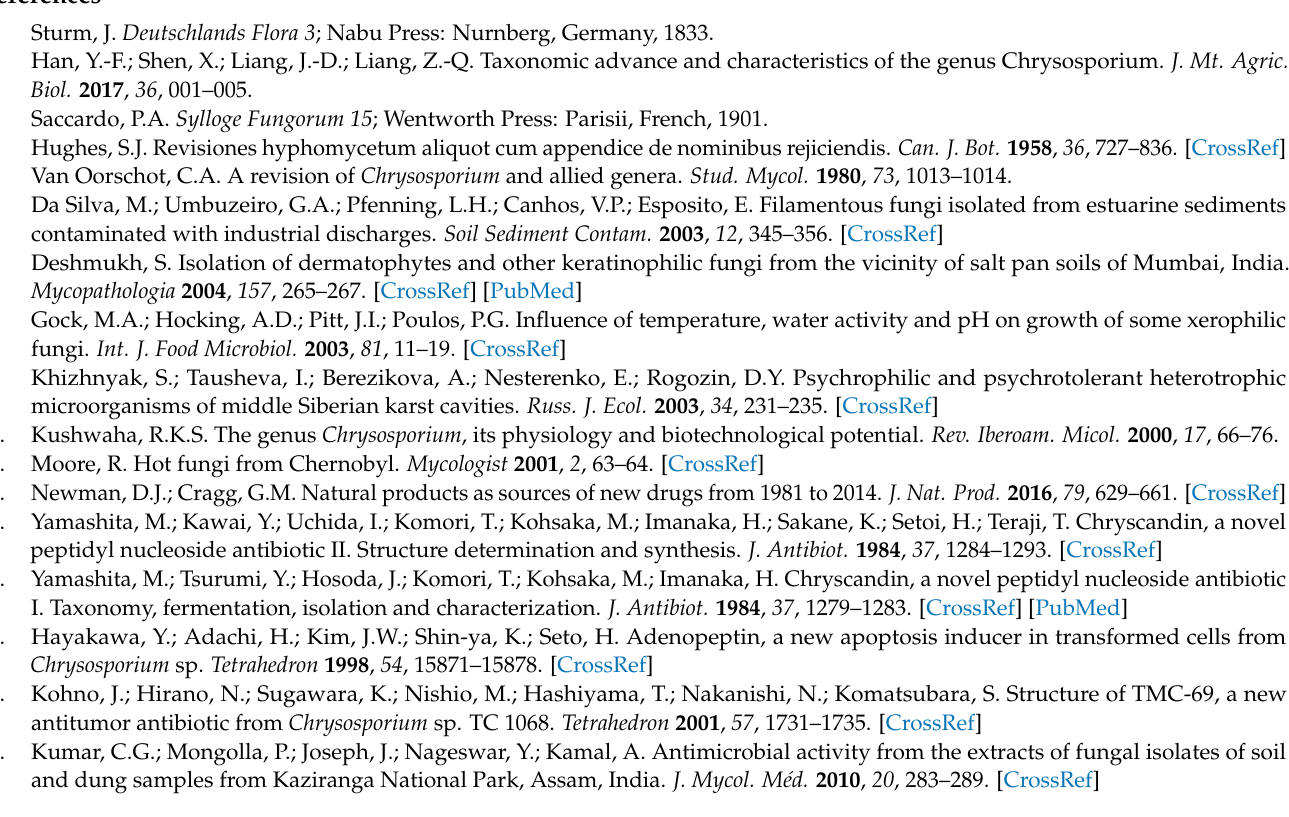
Figure 15. The number ( A ) and percentage ( B ) of Chrysosporium isolated compounds with different bioactivities from 1984 to